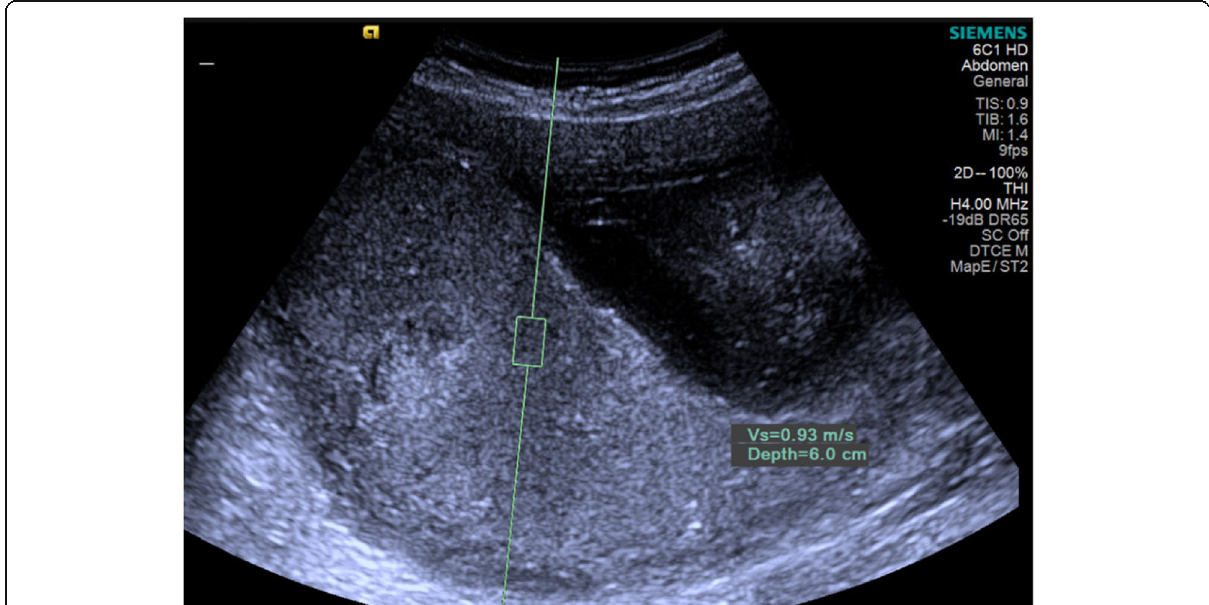
Fig. 2 Normal pregnancy aged 37 weeks. Normal posterior placenta, SWV = 0.93 m/s, depth 6.0